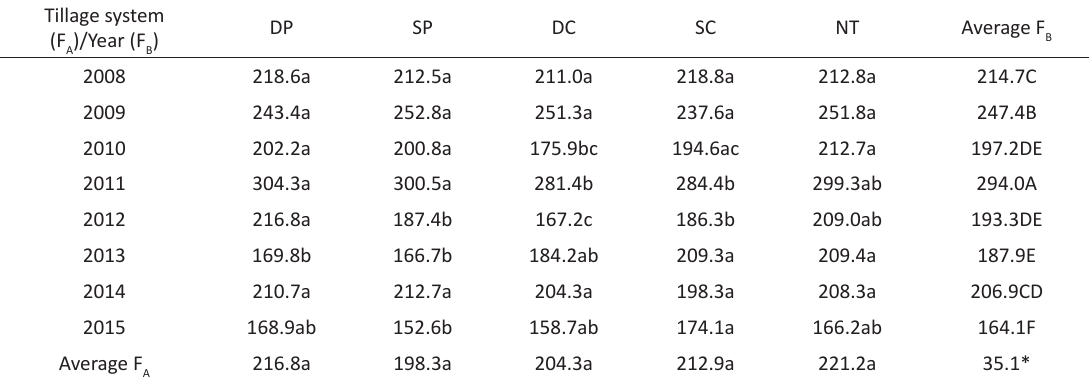
Table 6. The impact of the tillage systems on the height of maize canopy (cm) Tillage system (F